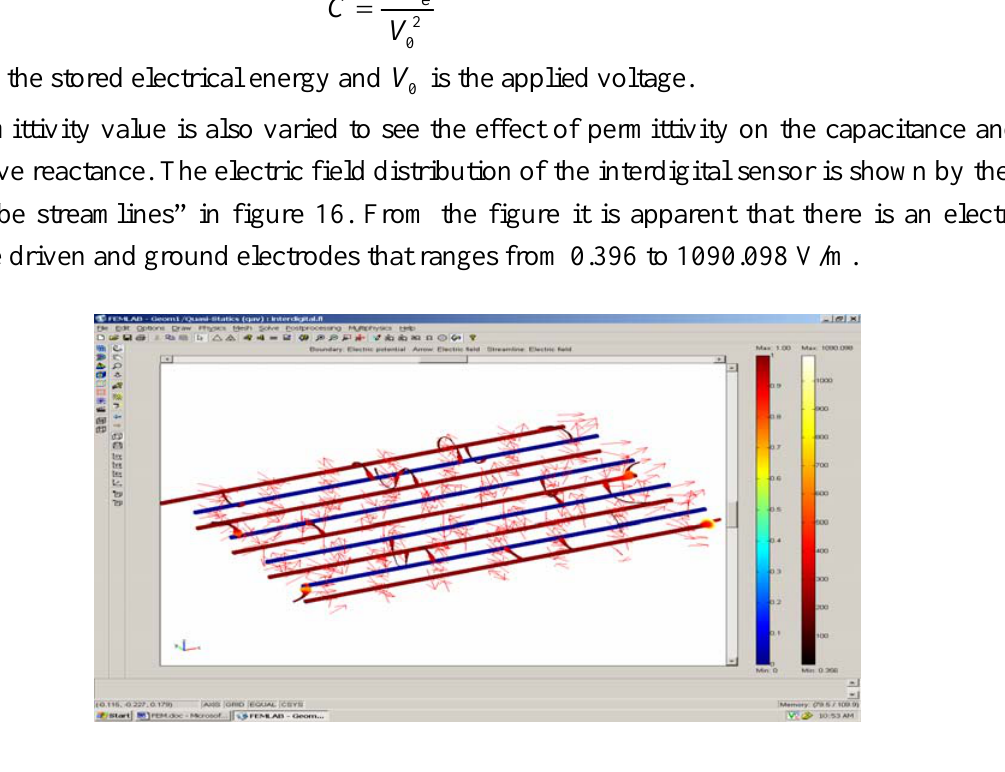
Figure 16. Solution of interdigital type